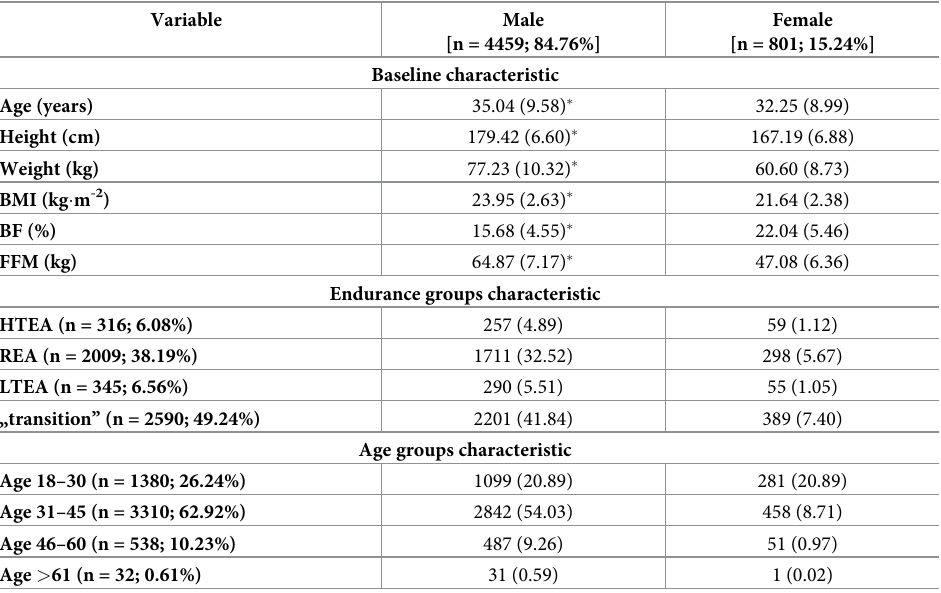
Table 1. Participants’ basic anthropometric